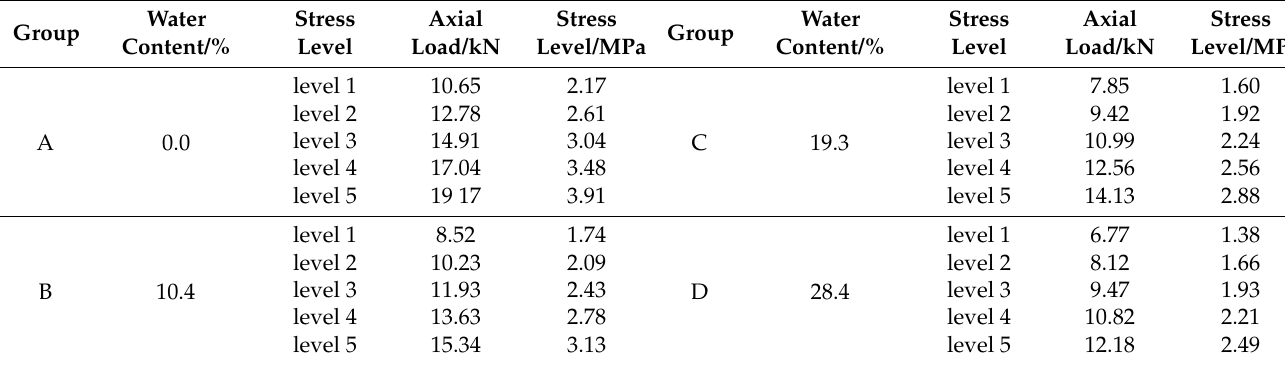
Table 2. Loading parameters at each level of graded loading for uniaxial compression test.